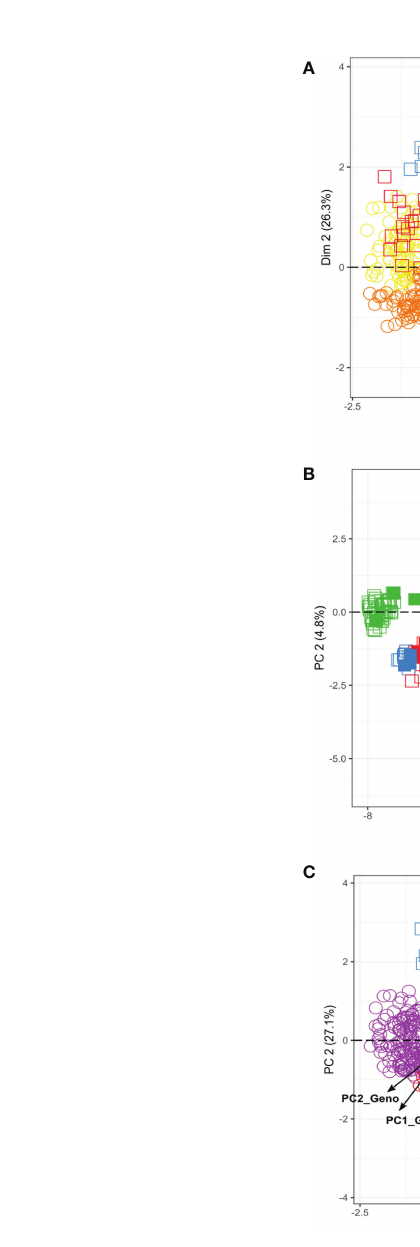
534.33 mg AAE) assays. Moreover, the three subpopulations presented similar values of AAC with means between 3.97 to 4.25 mg AA (Supplementary Table S4). On the other hand, tetraploid genotypes were divided into two highly diversi fi ed subpopulations (He=0.422) (Supplementary Figure S3C) with low genetic structure (Phi=0.040) (Table 1). At the phenotype